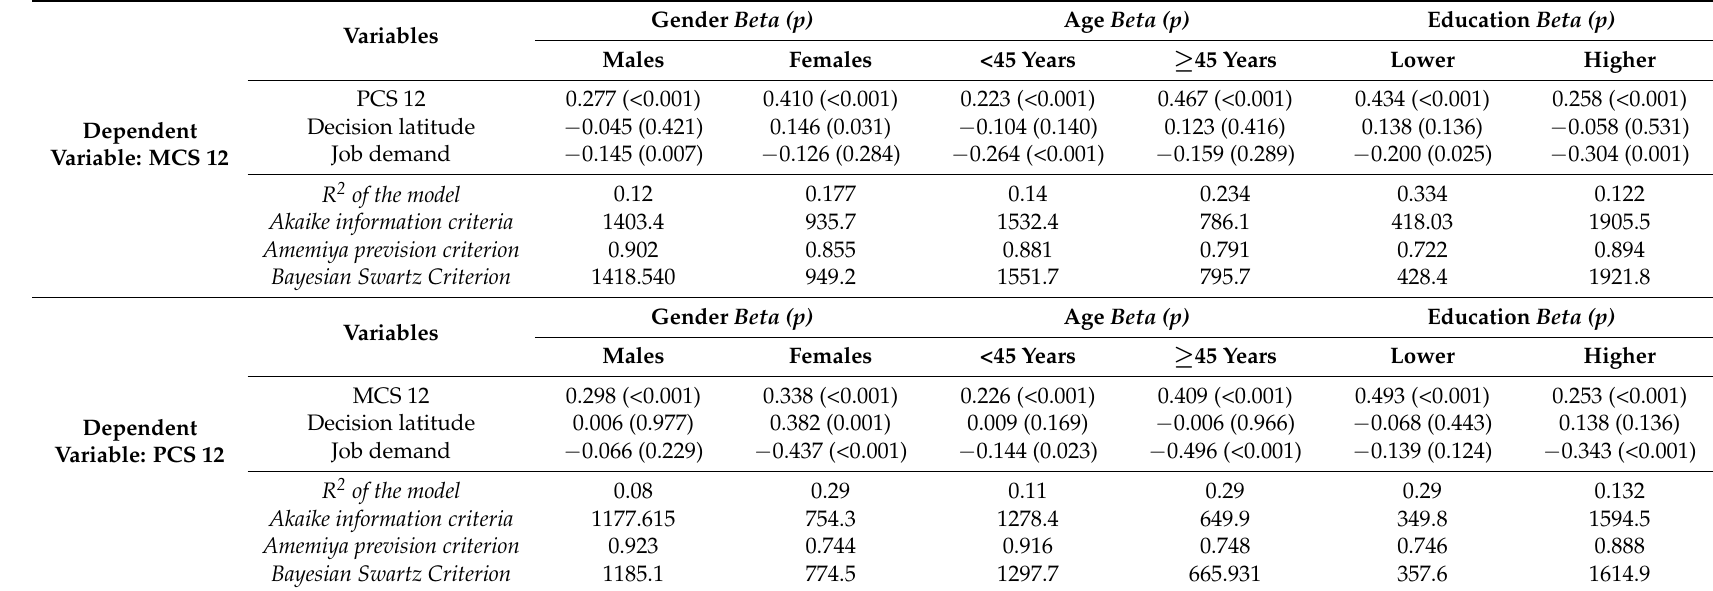
Table 3. Predictors of MCS 12 and PCS 12 stratified by gender, age and educational